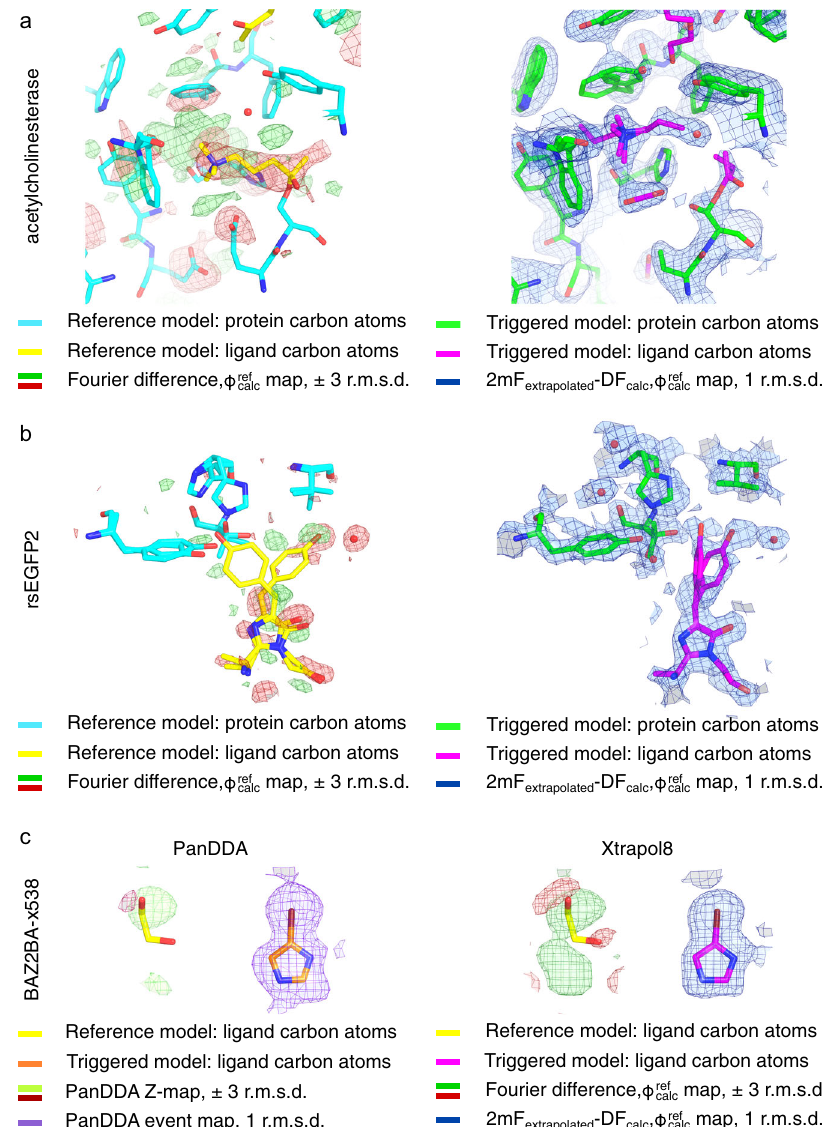
Fig. 5 Xtrapol8 enables extraction of low-occupancy states in time-resolved and ligand-based crystallography. In the Supporting results and discussion, we evaluate the versatility and performance of Xtrapol8 by revisiting other time-resolved (TRX), kinetic (KX) and ligand-binding crystallographic studies. For each case the Fourier difference map superposed on the reference state (with carbon atoms of the proteins and ligands colored in cyan and yellow, respectively) and extrapolated electron density map superposed on the triggered state model (with carbon atoms of the proteins and ligands colored in green and magenta, respectively) are shown. a A temperature-dependent KX study was conducted on the covalent complex of acetylcholinesterase with a non-hydrolysable substrate analog, whereby X-rays were used to radiolytically cleave bonds, including disul fi de bridges and the bond tethering the substrate analog to the catalytic serine 35 . By use of extrapolation, deeper insights could be obtained revealing two binding poses for the radiolytically produced carbocholine product, trapping of CO 2 from radiolysis of buried acidic residues. b A TR-SFX study was conducted on the reversibly fl uorescent protein rsEGFP2 with aim to determine the structure of the excited state that preludes isomerization and off -to- on fl uorescence switching 24 . Xtrapol8 allowed obtaining similar results as published earlier for the 1 ps time delay dataset. In the Supplementary results and discussion, we show that Xtrapol8 further allows extending the results obtained at the 3 ps time delay. c Comparison of the performance of PanDDA and Xtrapol8 in revealing the electron density of a small compound in a fragment-screening study (BAZ2BA-538) 36,37